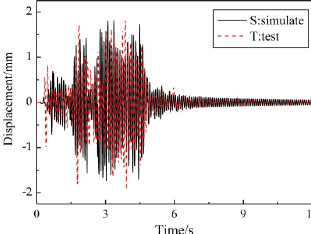
Figure 10. Comparison of roof-displacement response under Sy-2 condition.